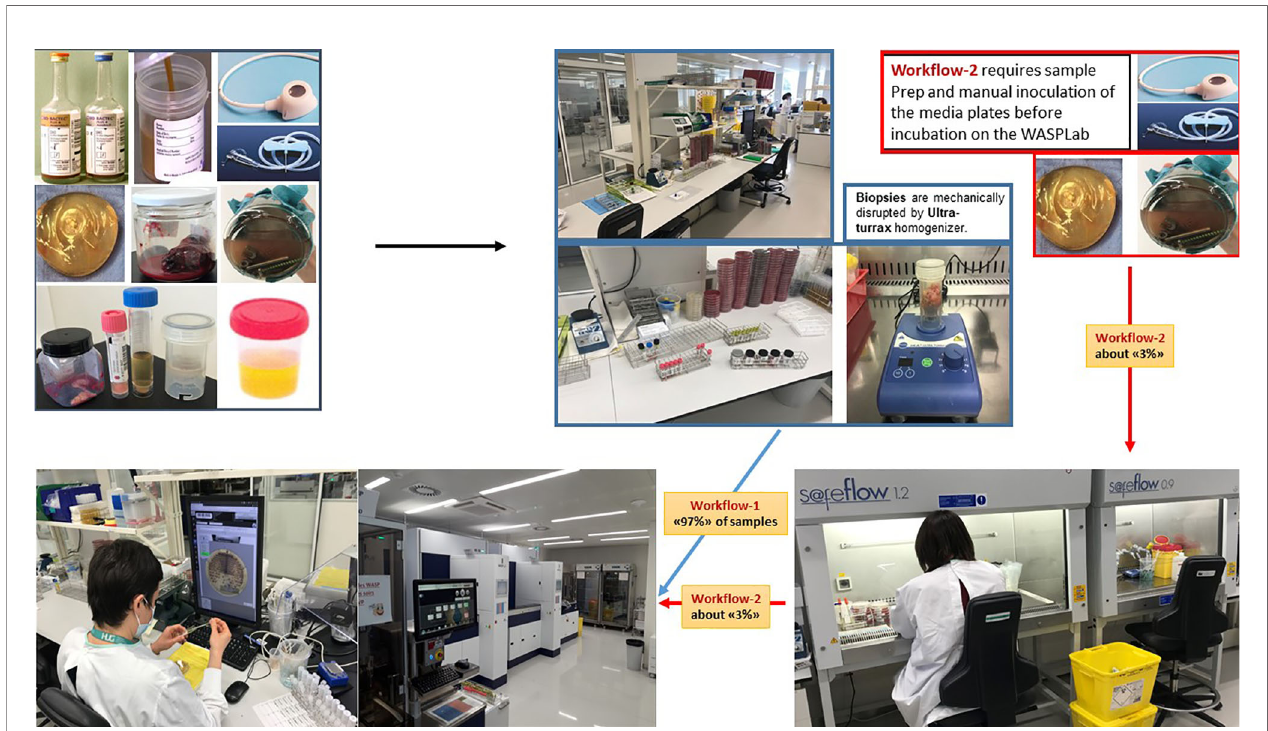
FIGURE 2 | Total Lab automation work fl ows. A supposed advantage of TLA in microbiology is an improved ef fi ciency by reducing the repetitive tasks with moderate added-value. Automated incubators with digital imaging drastically reduce the number of manipulations of the culture media plates. Currently, 97% of the identi fi ed “ automatable ” specimens are processed by TLA in our lab. The residual 3% corresponds to specimens that require manual sample preparation or manual inoculation of the media plates before incubation on the WASPLab (e.g., catheters, vascular or orthopedic prostheses, and chirurgical devices). Source of all